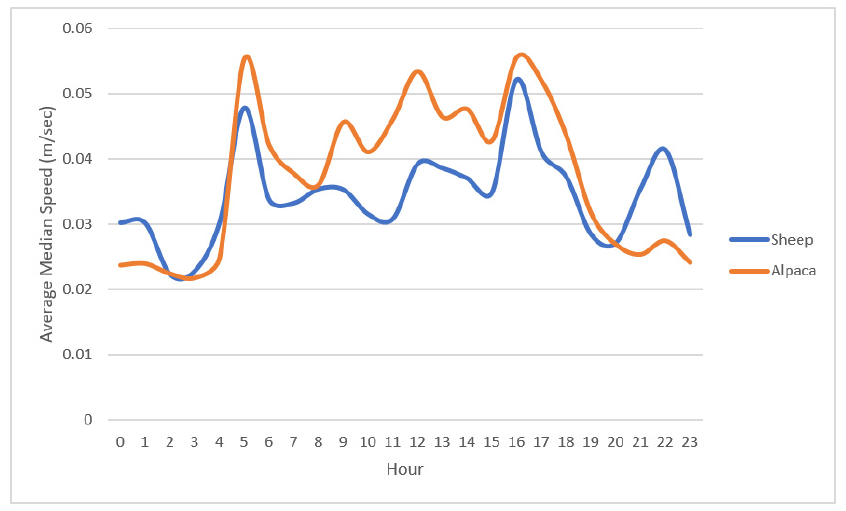
Figure 4. Median hourly speed (m/s) over 24 h of n = 10 ewes and n = 2 alpacas averaged over a 10-day observation period.